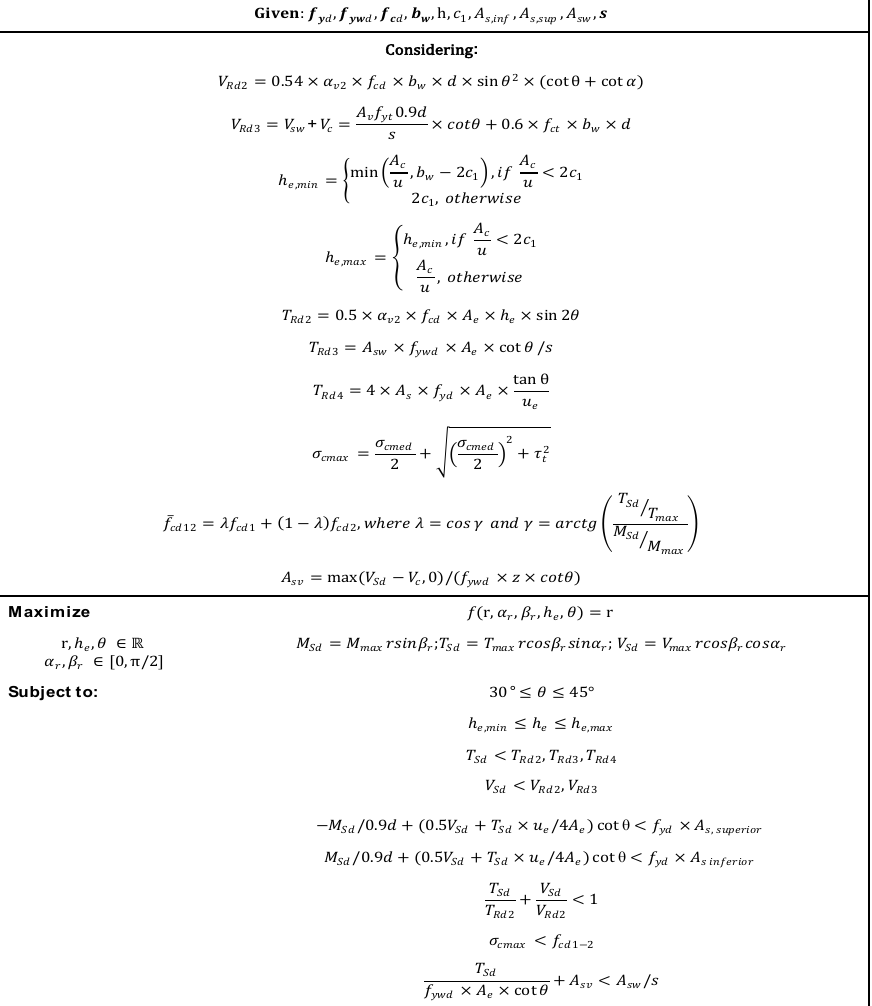
+ 𝐴𝐴 𝑟𝑟𝑣𝑣 < 𝐴𝐴 𝑟𝑟𝑒𝑒 / 𝑟𝑟 𝑓𝑓 𝑓𝑓𝑒𝑒𝑎𝑎 × 𝐴𝐴 𝑡𝑡 × cot 𝜃𝜃 Figure 14: Subroutine for Problem